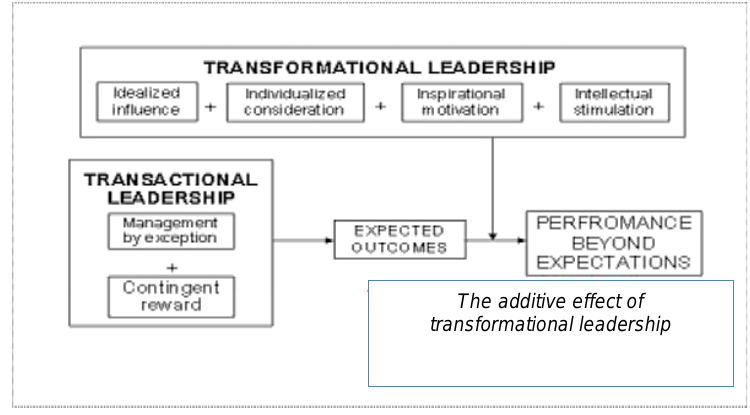
Figure 1: Transformational (authentic) and transactional leadership theories; Source: Bass and Avolio (1990)